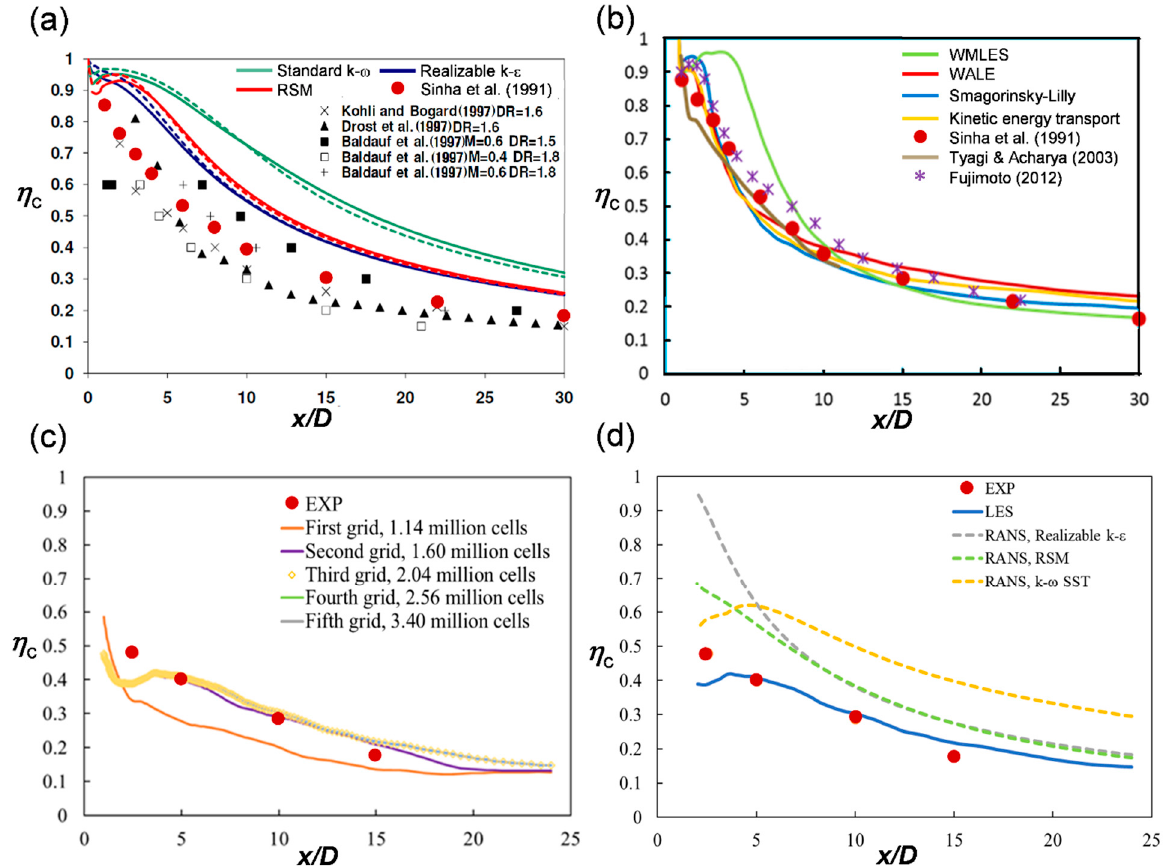
Figure 2. Code validation based on the centerline adiabatic film cooling effectiveness: ( a ) Turbulence model validation by Harrison and Bogard [15]; ( b ) subgrid scale model validation for the large eddy simulation (LES); ( c ) grid sensitivity test; and ( d ) code validation test compared to the data by Jung and Lee [11].